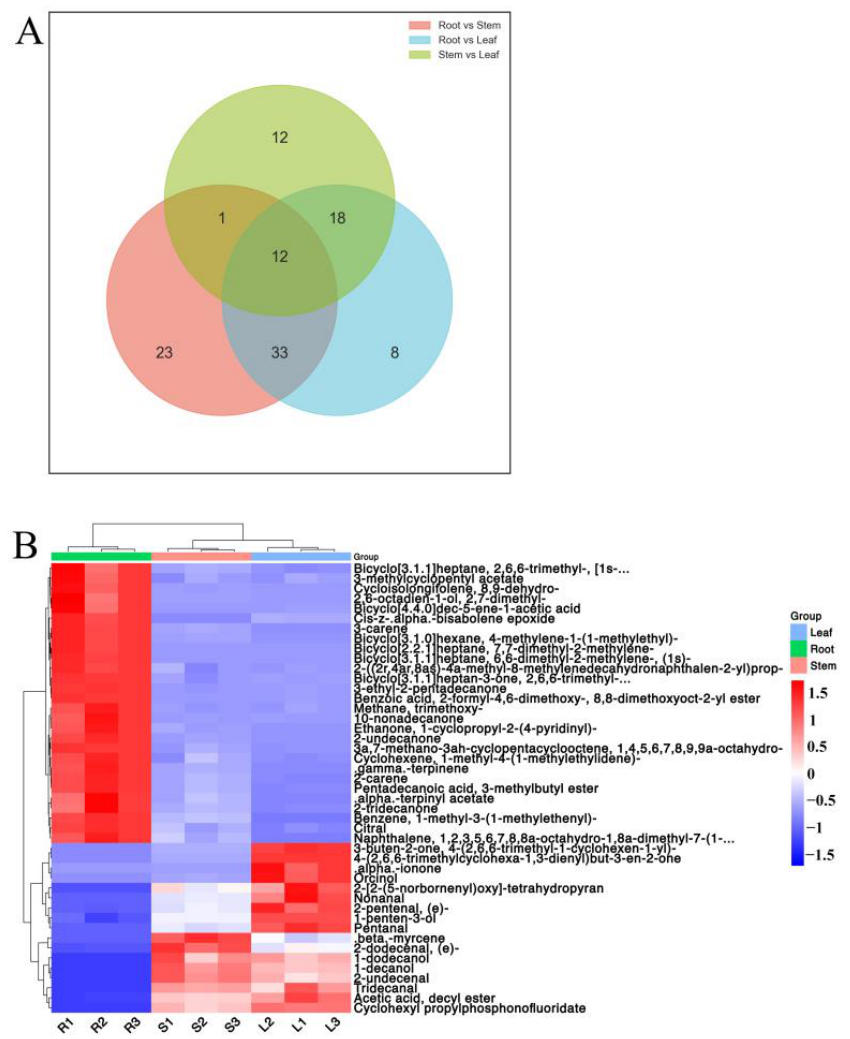
Figure 8. Specific differential metabolites in different parts of Houttuynia cordata . ( A ) heat map of differential metabolites. The color sequence from red to blue indicates metabolites abundance from high to low; ( B ) Wayne diagram. Table 2. Identification results of differential metabolites from different parts of Houttuynia cordata .